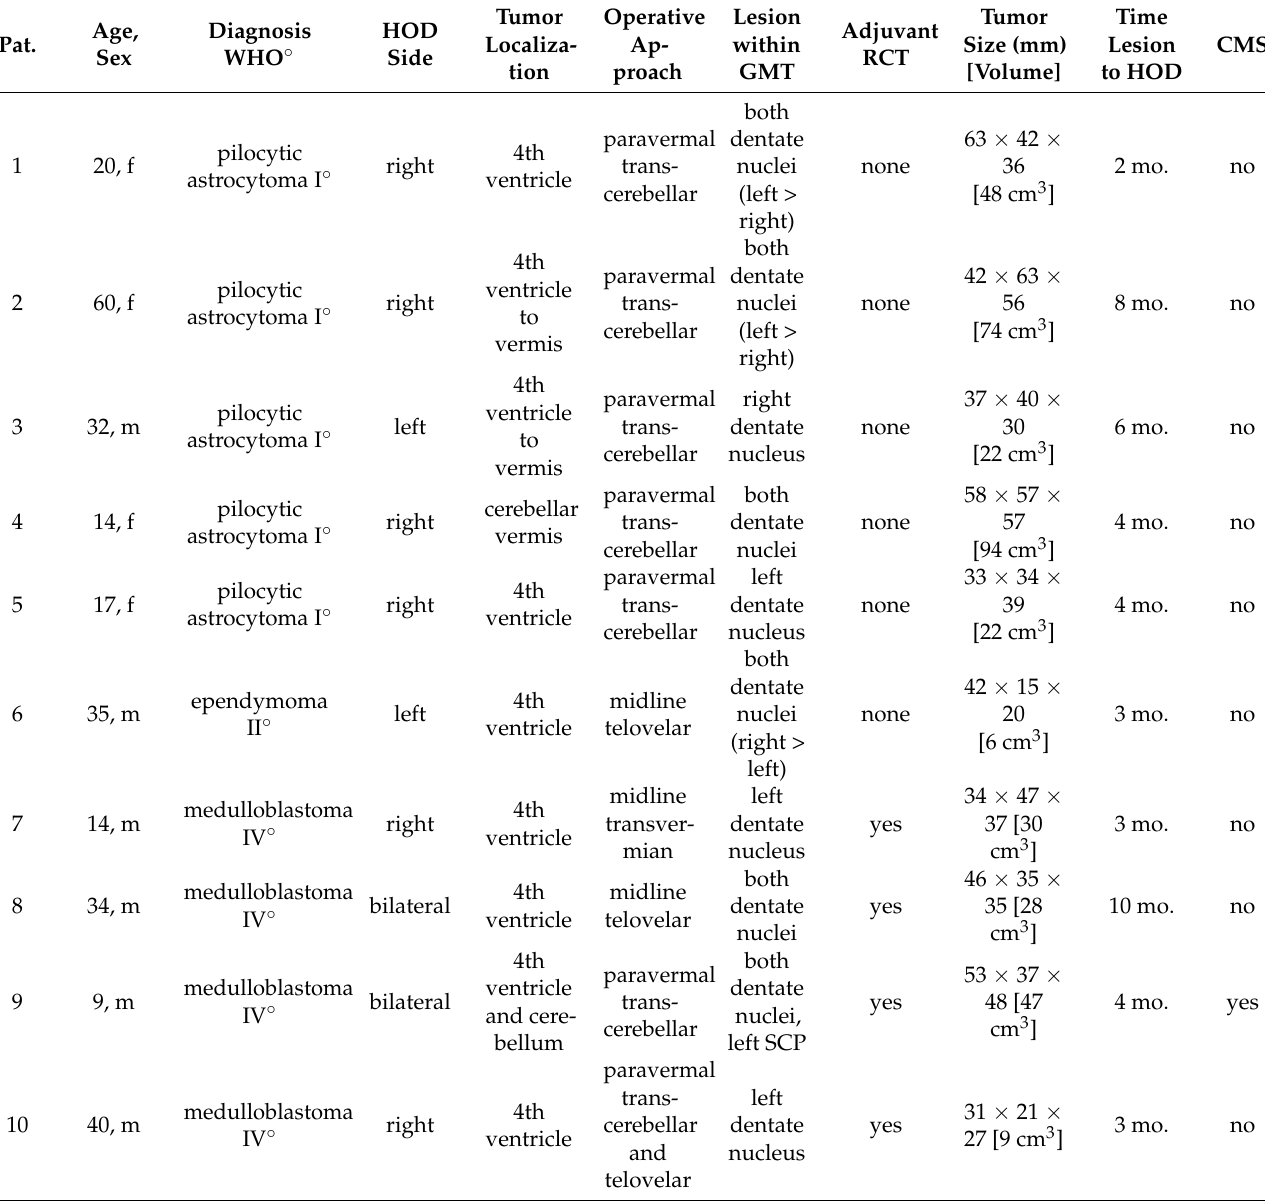
Table 2. HOD patient baseline data. The characteristics of ten patients with HOD development on MRI are shown. Age is defined as age at the time of the initial diagnosis of the brain tumor. Diagnosis is based on histopathology. The surgical approaches are listed as taken from the OR-reports. Latency resection to HOD is defined as time in between the first surgical operation to first radiological signs of HOD on MRI, months are rounded up for >2 weeks. HOD symptoms are defined as palatal tremor, Holmes-tremor and pendular nystagmus. Tumor size volumes were calculated using the ABC/2 estimation formula based on MRI-data [40]. Abbreviations: Pat. = Patient; mo. = months; CMS = cerebellar mutism syndrome; m = male; f = female; SCP = superior cerebellar